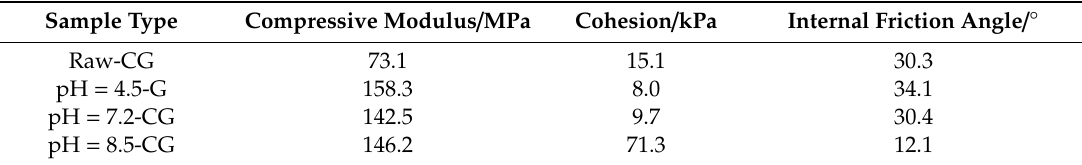
Table 2. Basic mechanical properties.